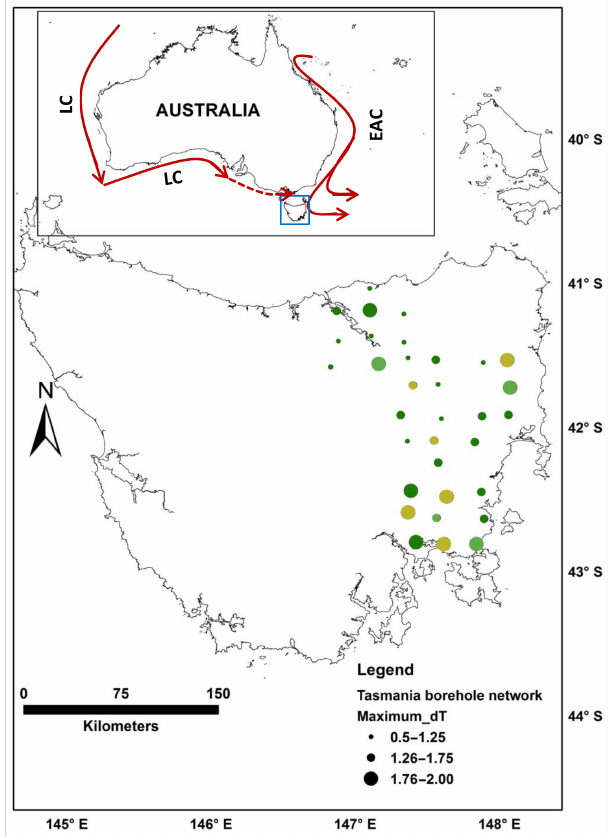
Figure 9. Spatial variation in regional GTC in Tasmania during the past 500 years. The colours represent area misfit between measured and modelled downhole temperature data. Dark green: <0.04; pale green: 0.04–0.06; khaki: >0.06 (to 0.08)m 2 m − 1 . Symmetric repre- sentation and flow directions of two major current systems around Australia are presented in the inset: the EAC and the LC (dashed line represents the extent of Leeuwin current during La Niña phase).